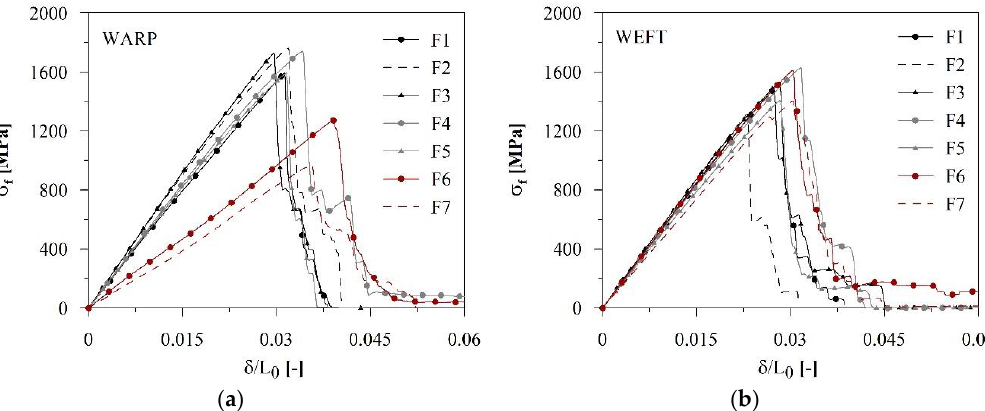
Figure 3. Fabric average tensile responses in terms of load vs. displacement: in the warp direction ( a ); and in the weft direction ( b ).